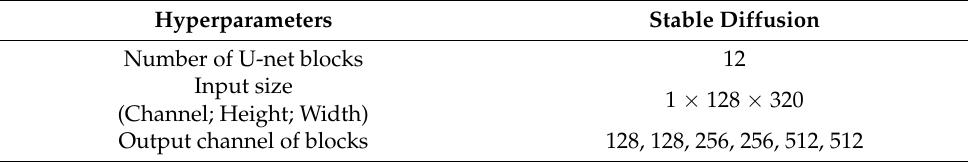
Table 4. Hyperparameters of the baseline model.